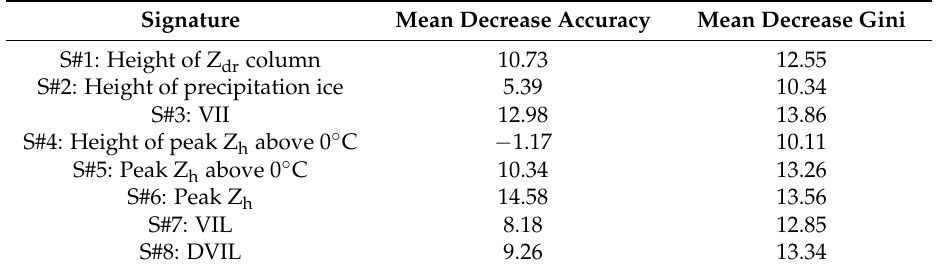
Table 3. Random Forest’s Mean Decrease Accuracy and Mean Decrease Gini for all radar